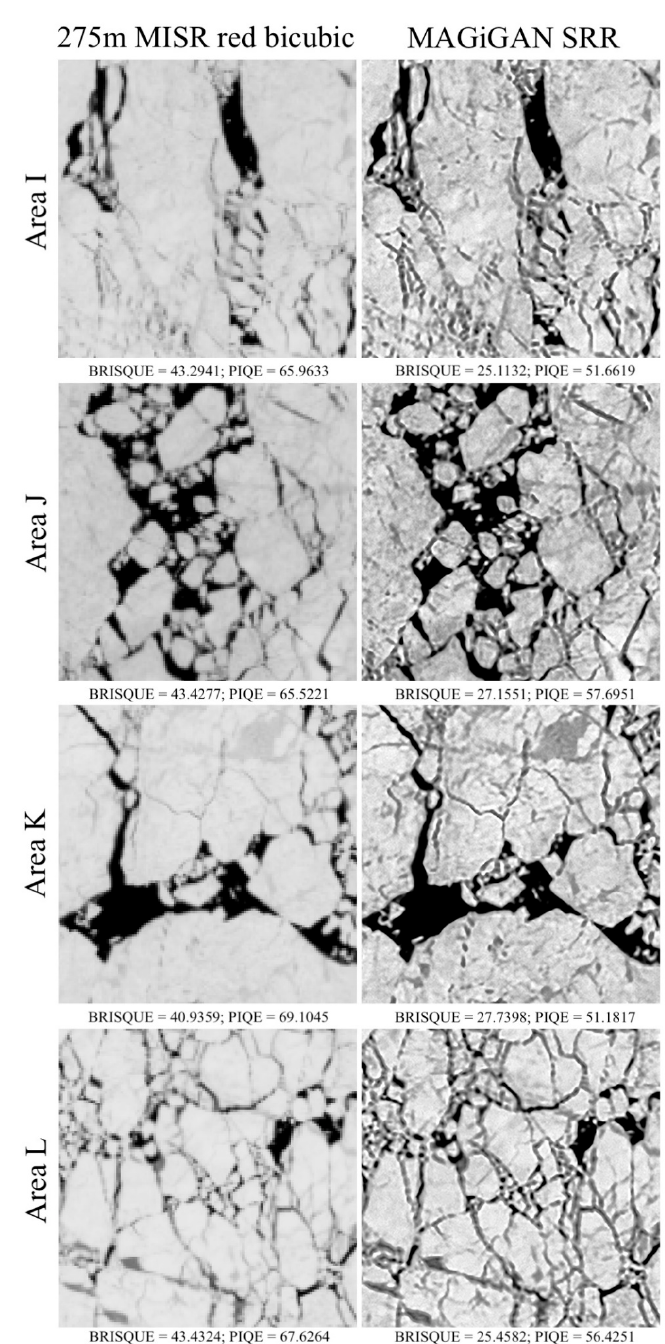
Figure 5. MISR red band SRR results at the sea ice field in comparison with the original 275 m MISR red band image (bicubic interpolated to the same scale as SRR image). BRISQUE and PIQE scores are provided below each image.